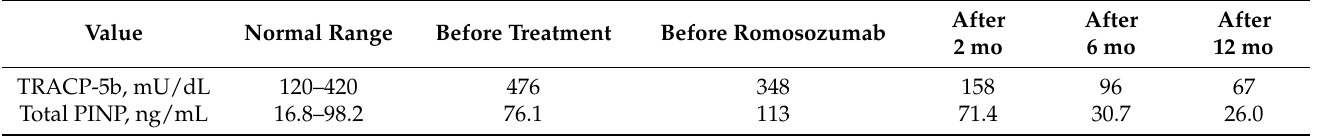
Table 1. Laboratory test of the patient on first visit, before and after romosozumab treatment.